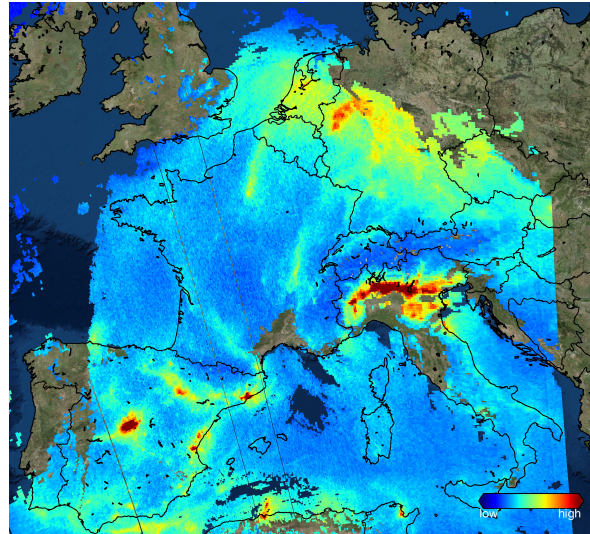
Figure 2. Copernicus-Sentinel5P’s map of NO2 concentration on Europe (7x7km) . c (cid:13) BSC